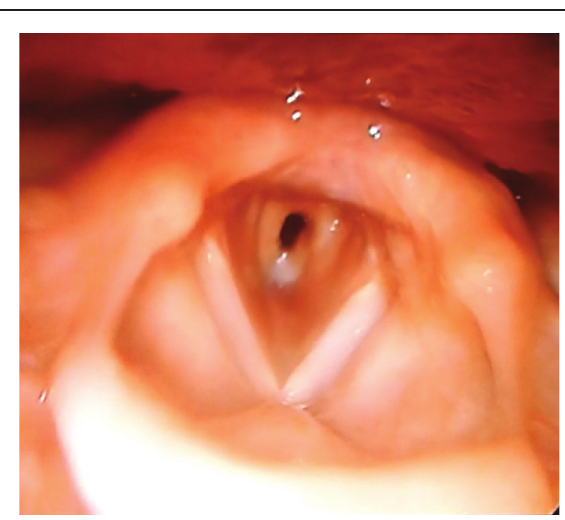
Laryngeal examination using 90 ° endoscope showing granulations above the upper end of tracheal